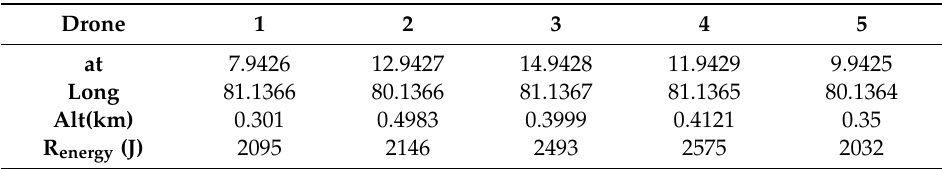
Table 3. The calculated values of distance and B opt attained after the first iteration.